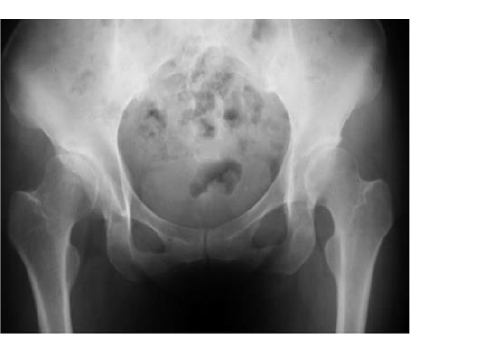
Figure (1): Retroverted acetabulum and cross-over sign